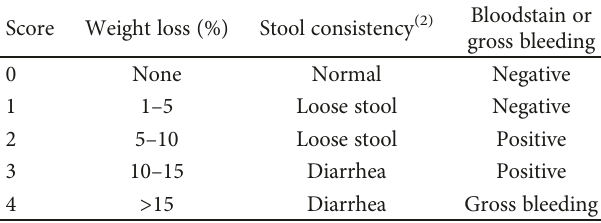
Table 1: Criteria for scoring the DAI (1) .